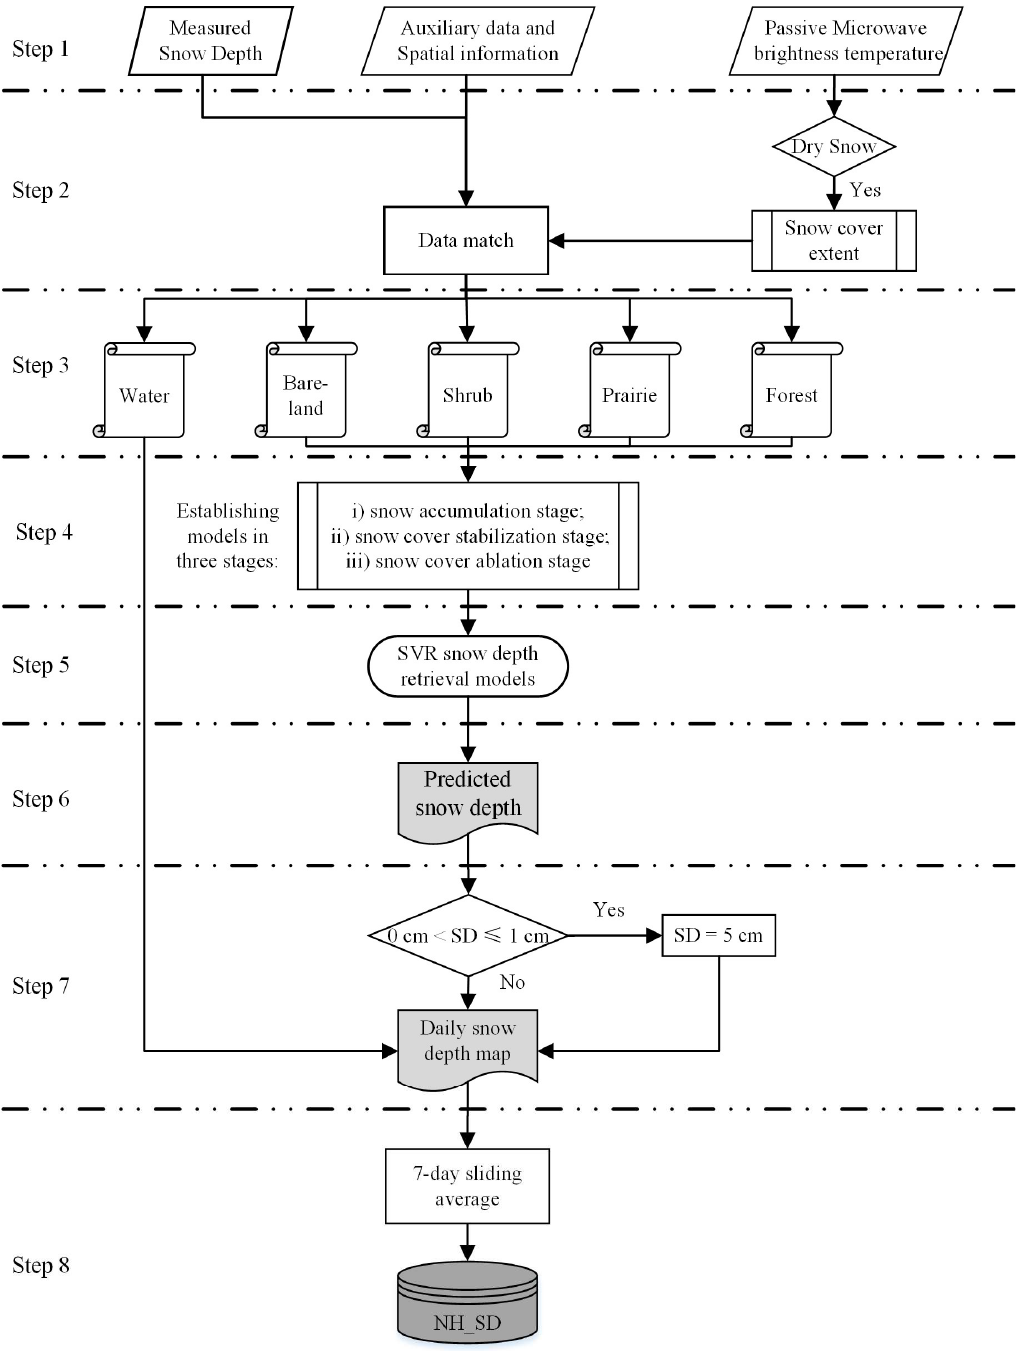
Figure 2. Process flowchart diagram for developing the Northern Hemisphere’s daily snow depth and snow water equivalent data.